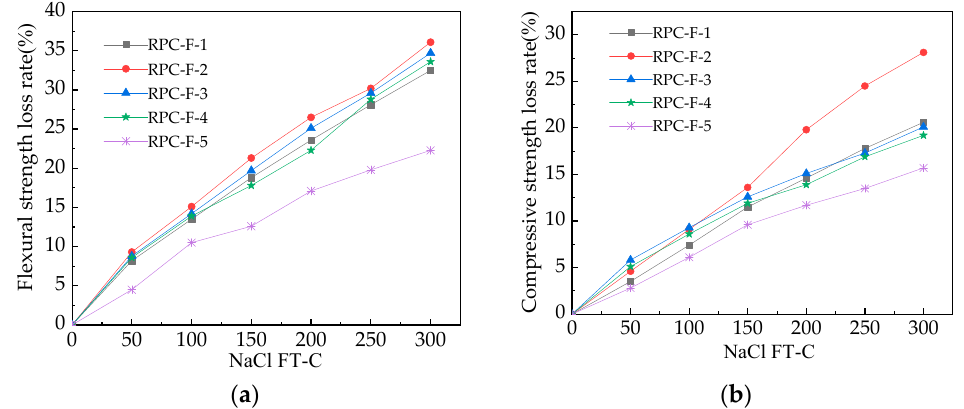
Figure 6. Mechanical strength loss rates after NaCl FT-C. ( a ) Flexural strength loss rate ( b ) Compressive strength loss rate.